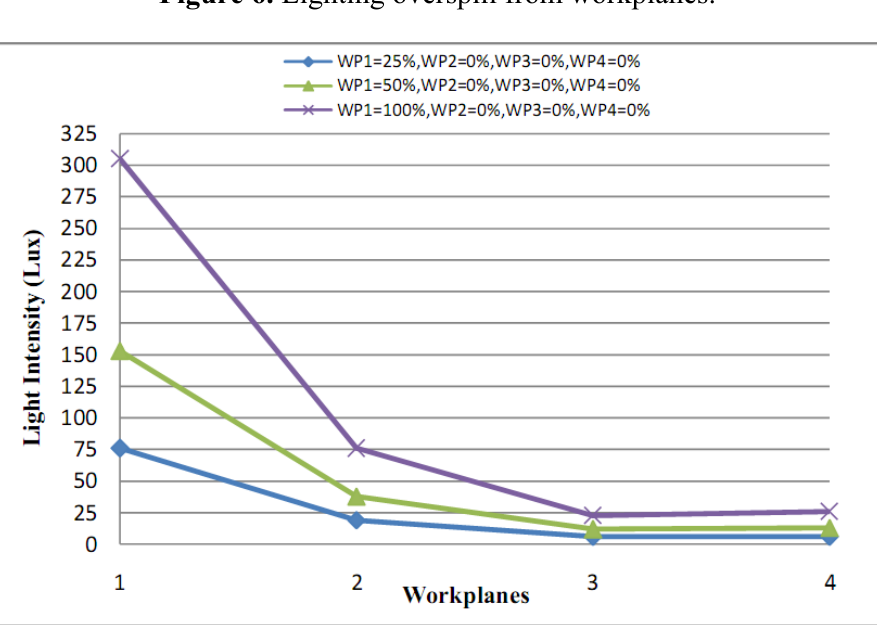
Figure 6. Lighting overspill from